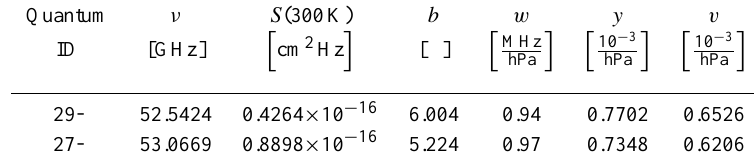
Table 3. List of used line parameters for O 2 . The data are from the PWR93 oxygen absorption model (Rosenkranz, 1993).